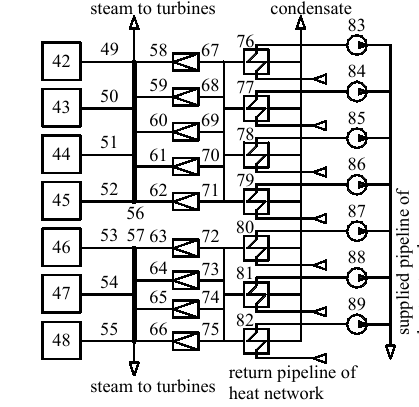
Fig. 3. Aggregated technological scheme of CHP- 5 of DHS in Shelekhov